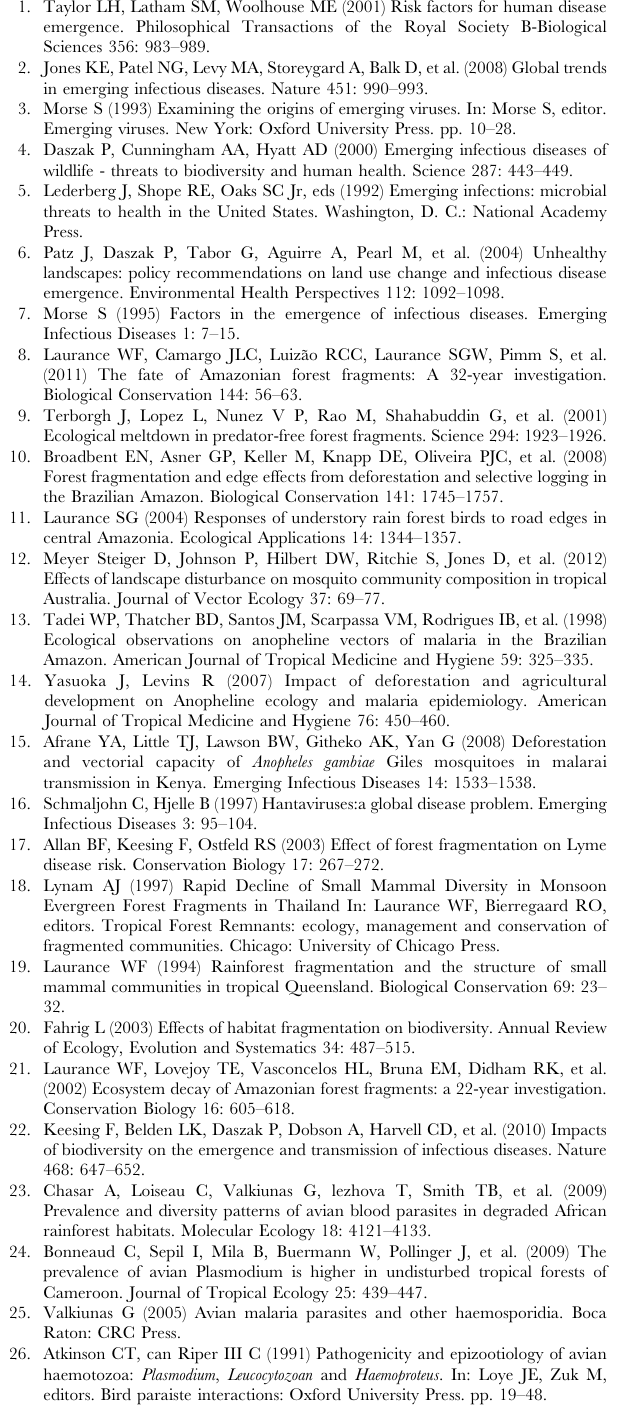
Figure 4. Associations between blood-parasite infections and the ecological traits of birds, assessed using Chi-square tests.